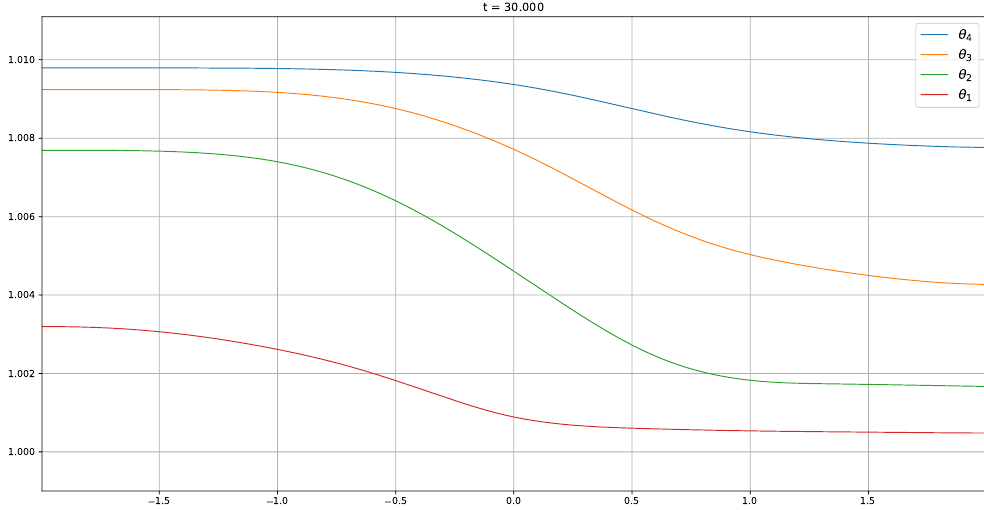
Figure 4. Simulation with M = 4 number of layers for a version of the code without an upwind approximation. The relative density θ α is shown.